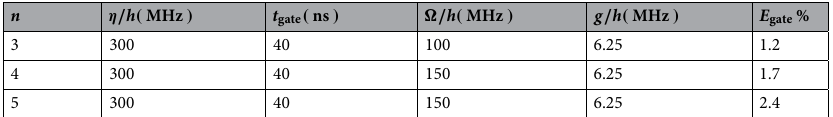
Table 1. Performance of simultaneous n -target CNOT gate in complete graph of n + 1 transmon or Xmon qubits, using realistic models for the qubits and couplers. Here η is the qubit anharmonicity, t gate is the gate time excluding the single-qubit rotations in (34), (cid:31) is the microwave Rabi frequency, and g is the coupler strength. The reported gate error is E gate = 1 − |� (cid:31) | U † ideal U | (cid:31) �| 2 , where U ideal is the ideal entangler (32),